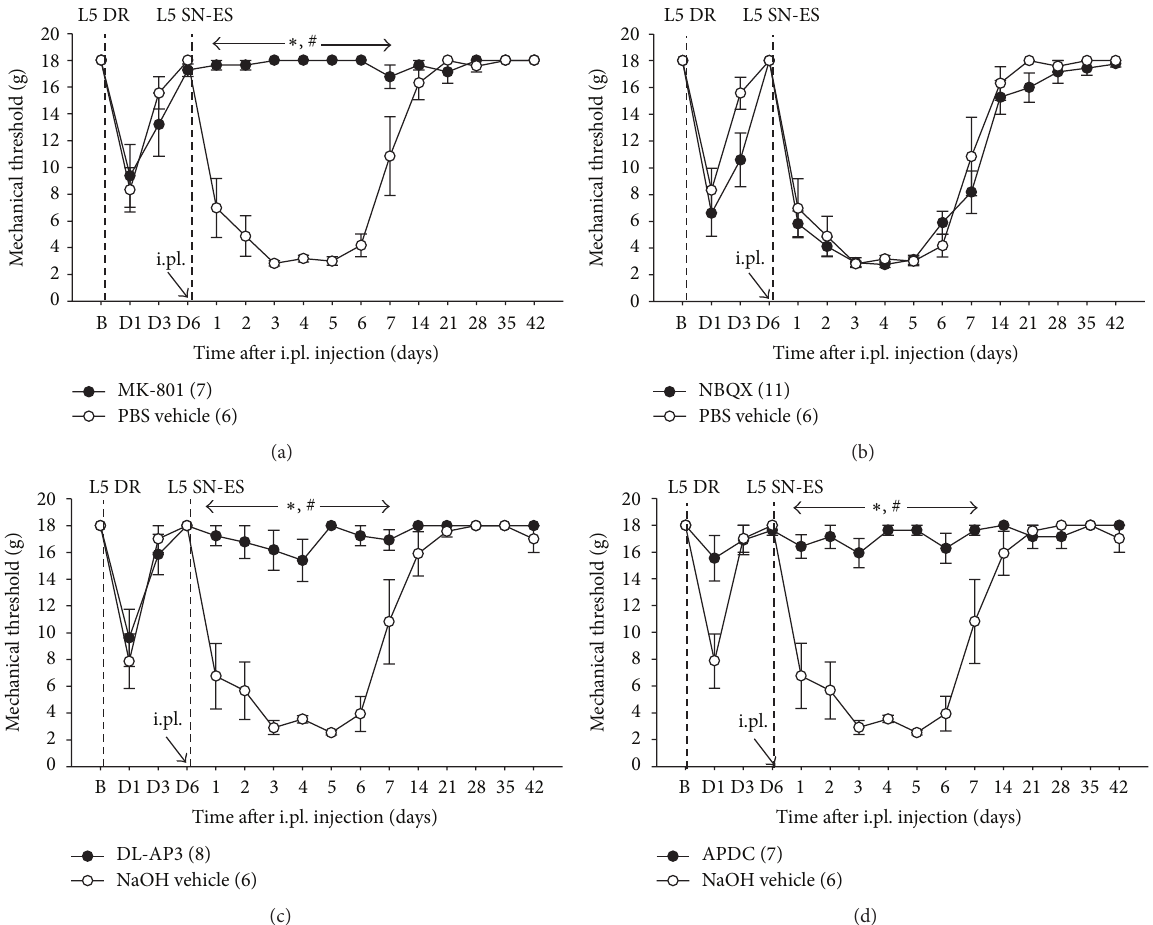
Figure 3: Effects of MK-801, NBQX, DL-AP3, or APDC pretreatment in the periphery on ES-induced PWT reduction. (a) In rats with L5 DR, an i.pl. injection of MK-801 (20 nM) administered immediately before the ES of L5 SN (L5 SN-ES) into the midpoint of the L4 plantar dermatome resulted in a significant increase in ES-induced decreased PWTs compared with vehicle-treated controls. (b) An i.pl. NBQX (100 nM) injection administered immediately prior to the ES produced no significant difference in ES-induced decreased PWTs from vehicle-treated controls. (c and d) Animals administered an i.pl. injection of DL-AP3 (70 nM) or APDC (20 nM) immediately prior to the ES exhibited a significant increase in ES-induced decreased PWTs compared with vehicle-treated controls. The abbreviations B and D are defined in Figure 2. The values in parentheses indicate the number of animals used. The error bars represent the SEM. ∗ 𝑃 < 0.05 versus vehicle groups. # 𝑃 < 0.05 versus